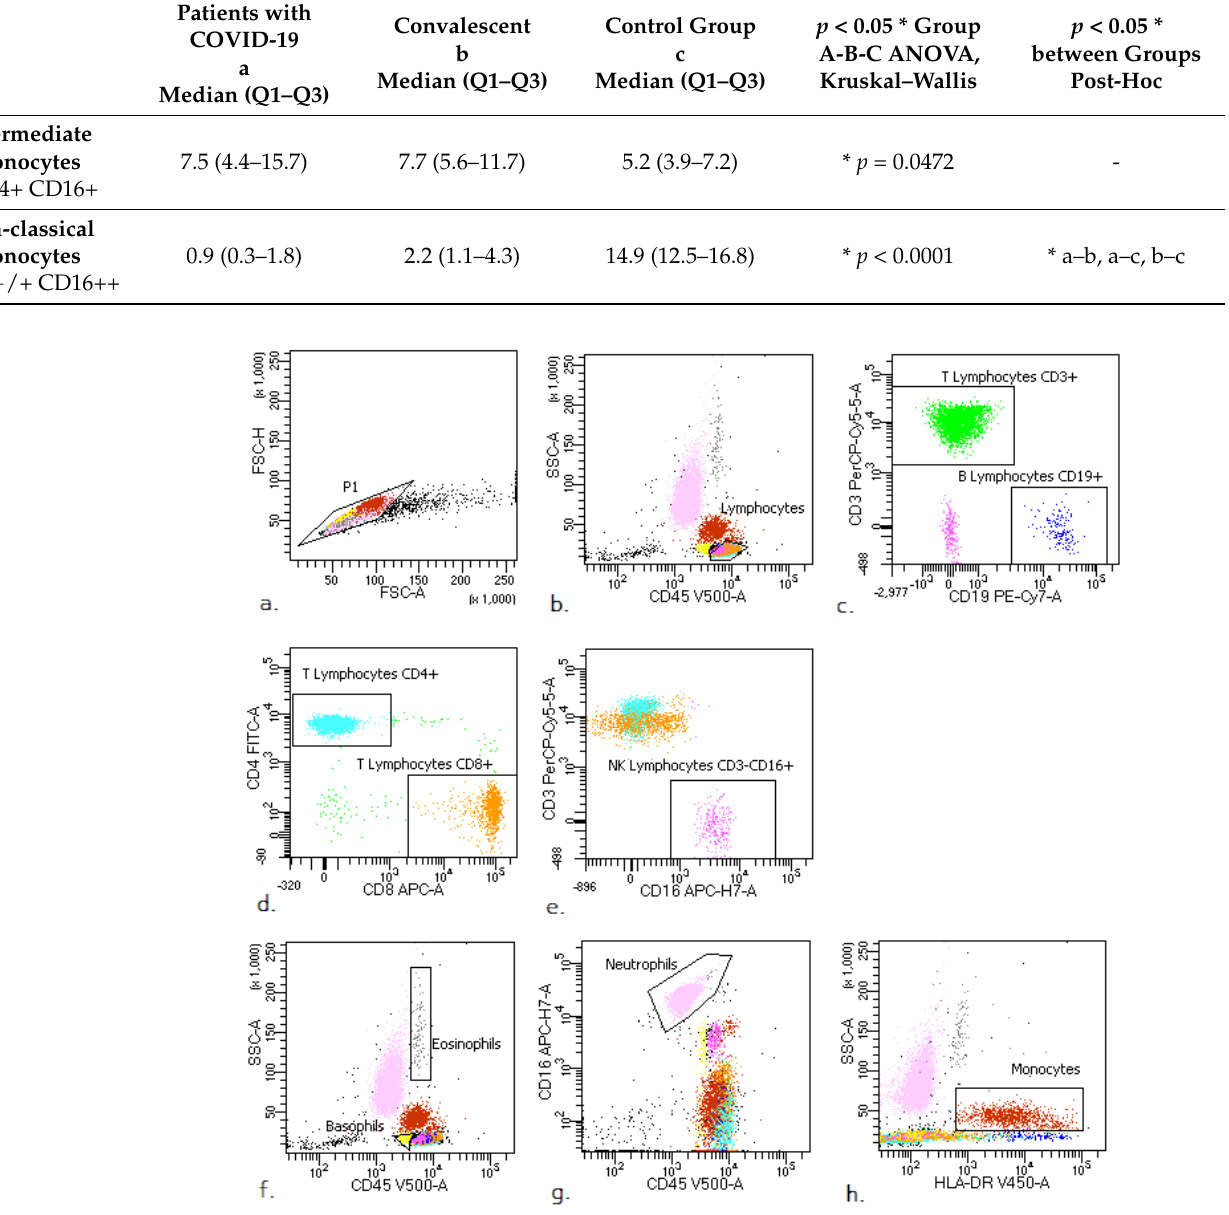
Figure A1. Representative leukocyte subsets’ gating strategy in peripheral blood (PB) of COVID-19 patients. ( a ) FSC-A vs. FSC-H plot: gating the cells that have an equal area and height (P1), thus removing clumps (greater FSC-A relative to FSC-H) and debris (very low FSC). ( b ) SSC-A vs. CD45 plot: selection of lymphocytes based on their SSClow/CD45+ properties. ( c ) CD3 vs. CD19 plot: selection of T lymphocytes (green) and B lymphocytes (blue) based on their CD3+ or CD19+ properties. ( d ) CD4 vs. CD8 plot: selection of CD4 (turquoise) and CD8+ cells (orange) based on their CD4+ or CD8+ properties. ( e ) CD3 vs. CD16 plot: selection of NK cells (pink) based on their CD16+ and CD3 − properties. ( f ) SSC-A vs. CD45 plot: selection of eosinophils (grey) based on their SSC-A+bright CD45+ properties. ( g ) CD16 vs. CD45 plot: selection of neutrophils (light pink) based on their CD45+dim CD16+bright properties. ( h ) SSC-A vs. HLA-DR plot: selection of monocytes (red) based on their SSC-A+dim HLA-DR+ properties (the exact antigenic characterization can be found in the text in Section 2, Flow cytometry analysis).